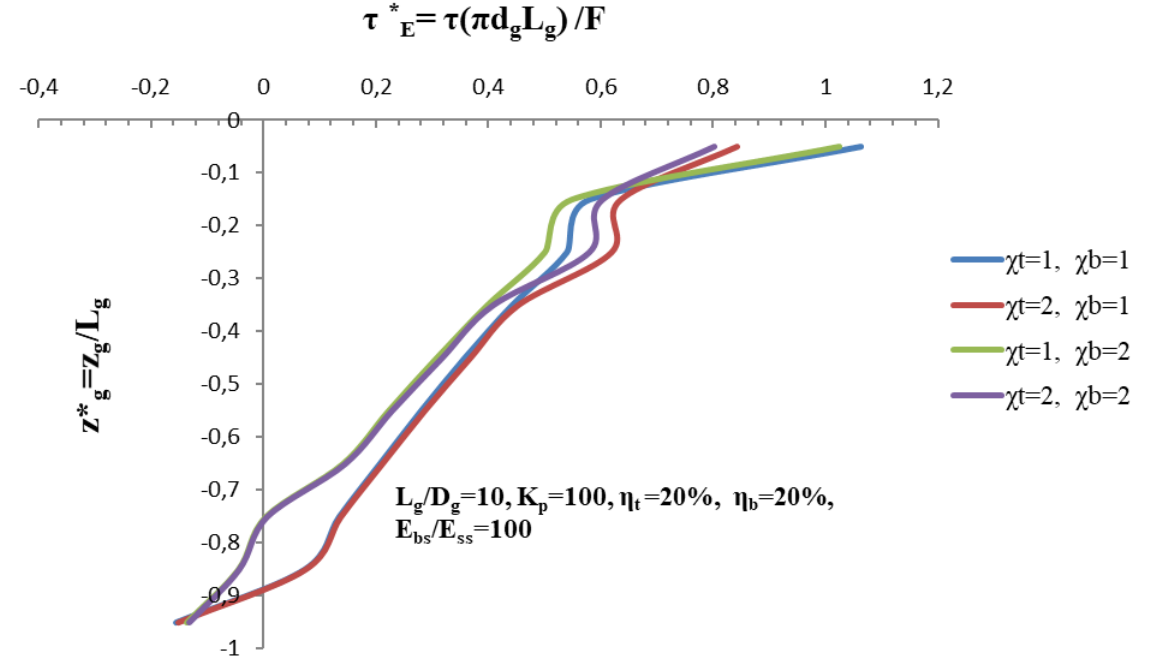
= τ(πD L )/F with normalized depth, z* E g g